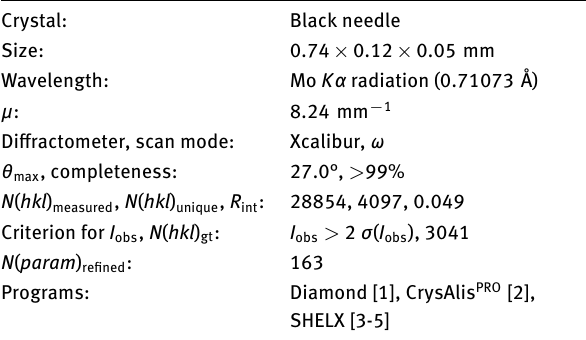
Table 1: Data collection and